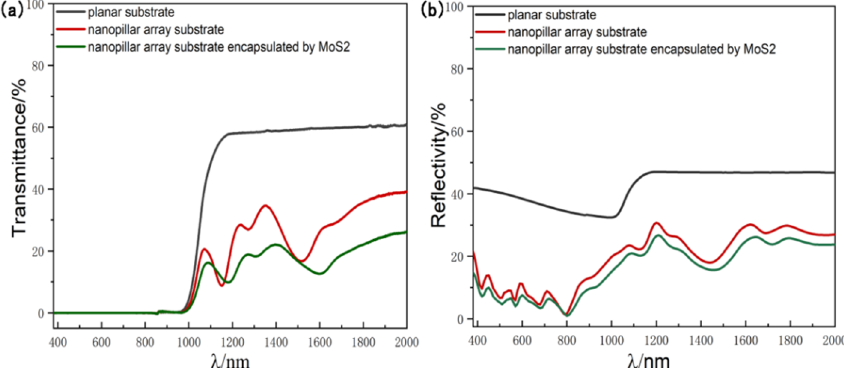
Figure 6. Transmittance ( a ) and reflection ( b ) properties of three kinds of substrates.